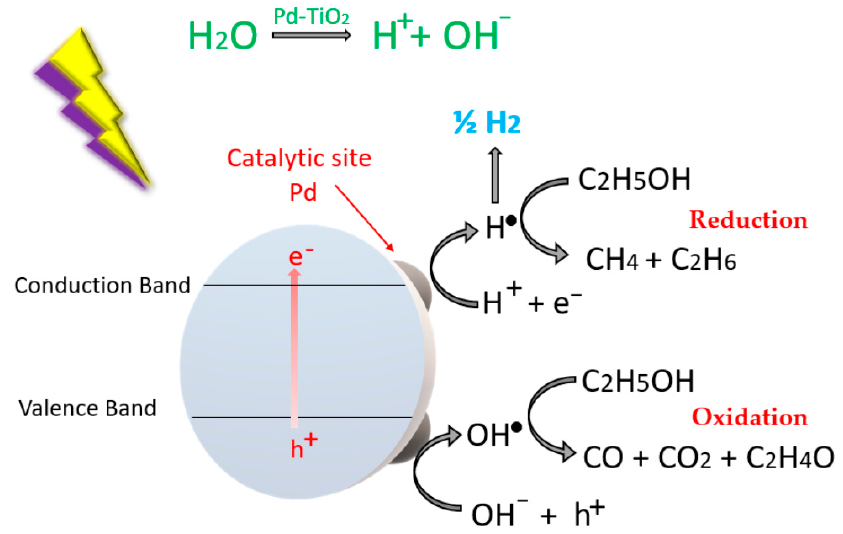
Figure 5. Schematic illustration of the three water splitting methods [94].